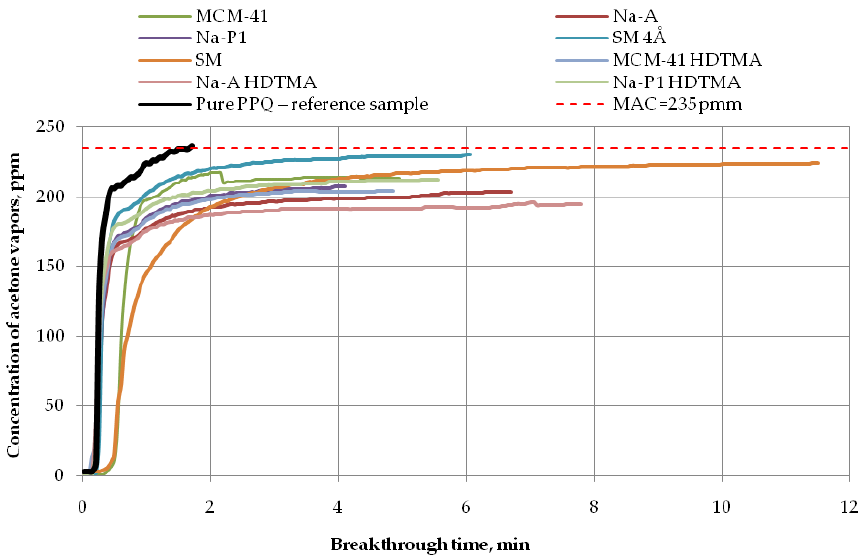
Figure 9. Breakthrough time for nonwoven zeolite and silica composites challenged with acetone at MAC = 235 ppm.